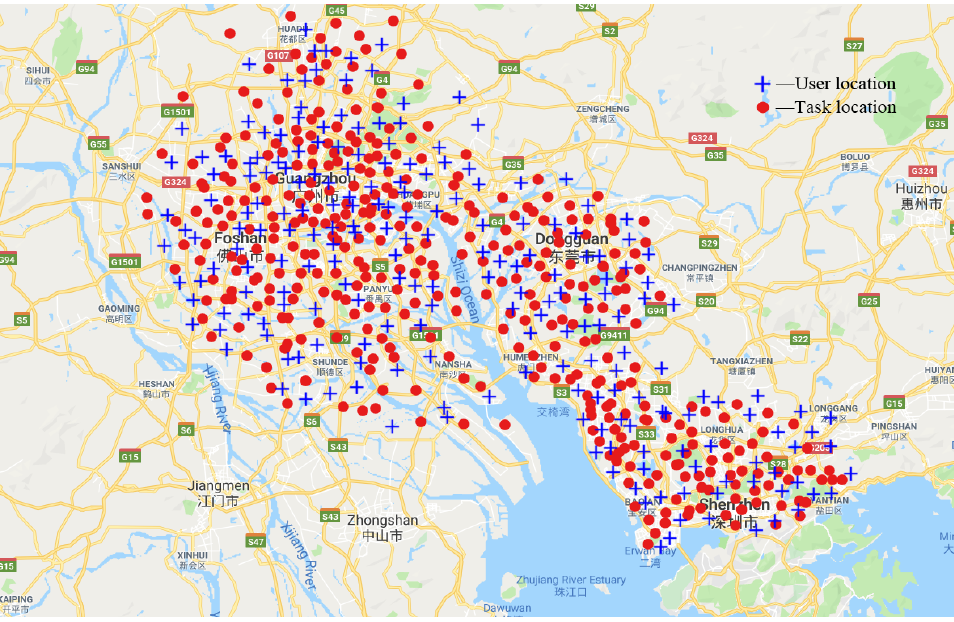
Figure 2. A real-world data set of task